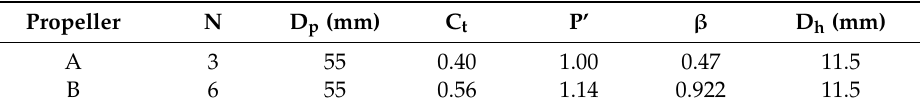
Table 2. Propeller